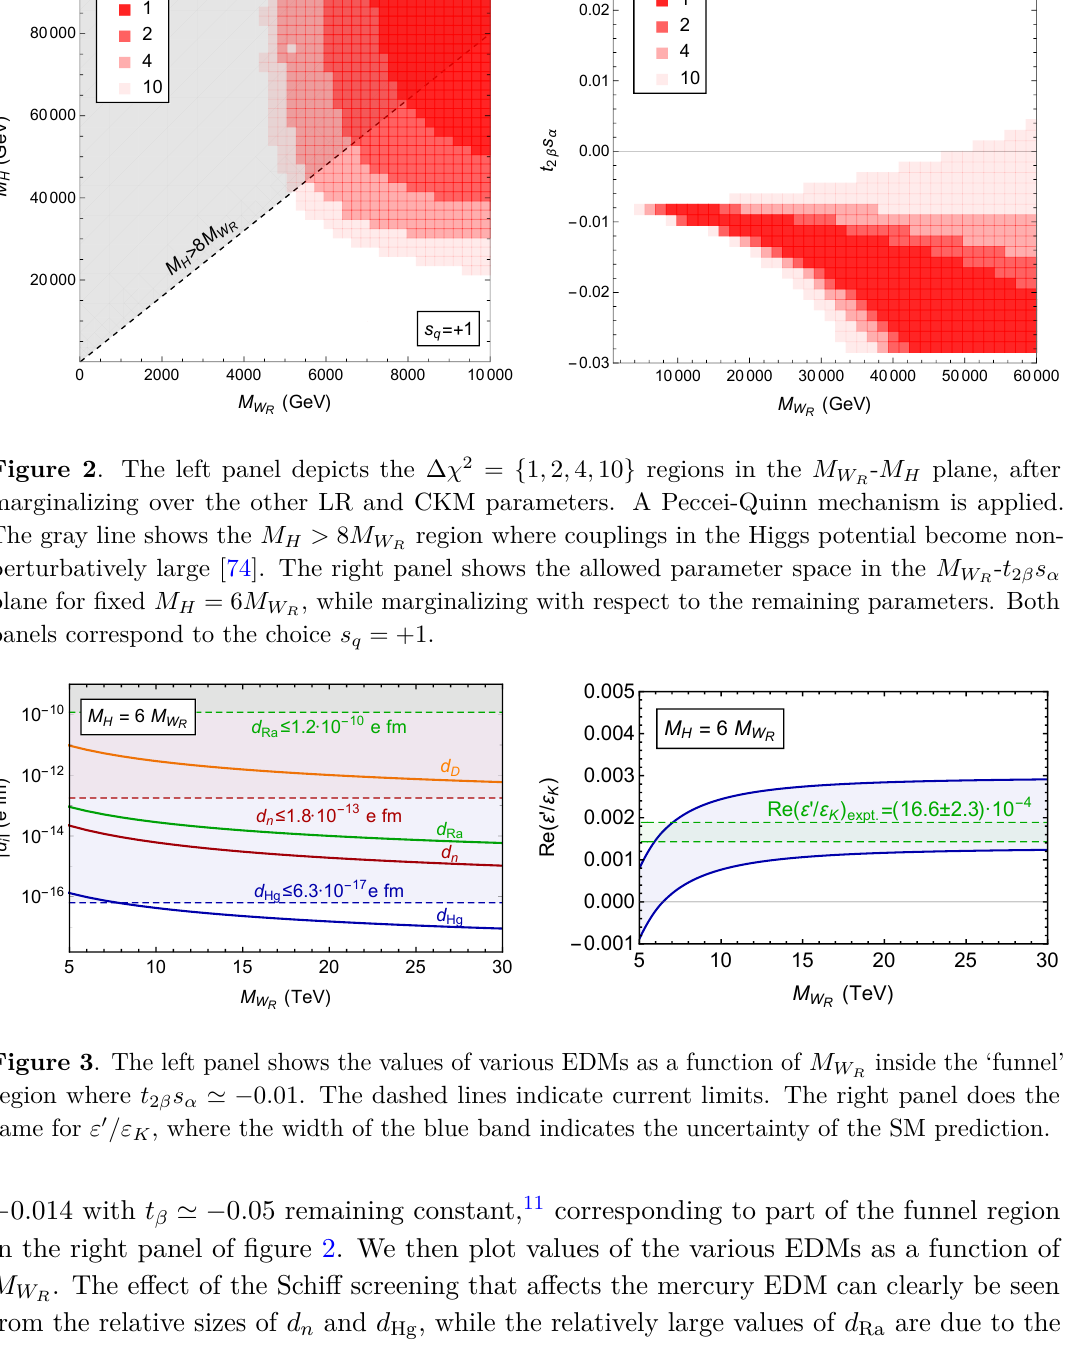
Figure 3 . The left panel shows the values of various EDMs as a function of M W region where t 0 . 01 . The dashed lines indicate current limits. The right panel does the 2 β s α ’ − same for ε 0 /ε , where the width of the blue band indicates the uncertainty of the SM K